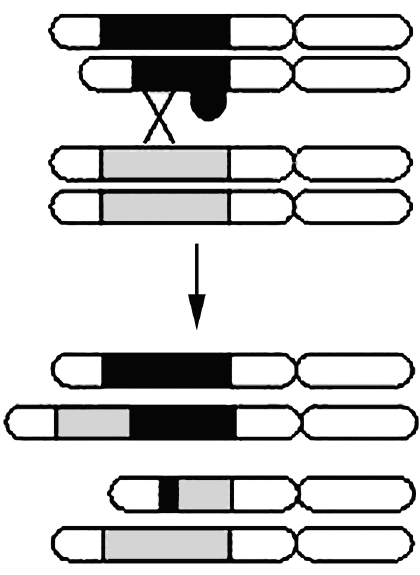
Figure 1 - Unequal crossing-over between homologous chromosomes. Black and gray regions correspond to microsatellite repeat sequences.